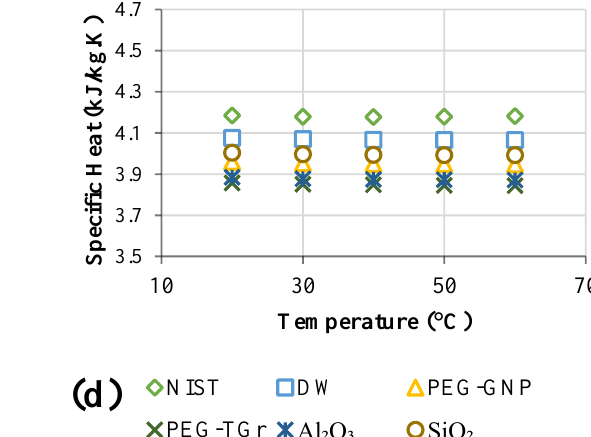
PEG@GNP = 5.3%, PEG@TGr = 4.5%, Al 2 O 3 = 2.6%, and SiO 2 = 1.2% for 0.1 wt.%